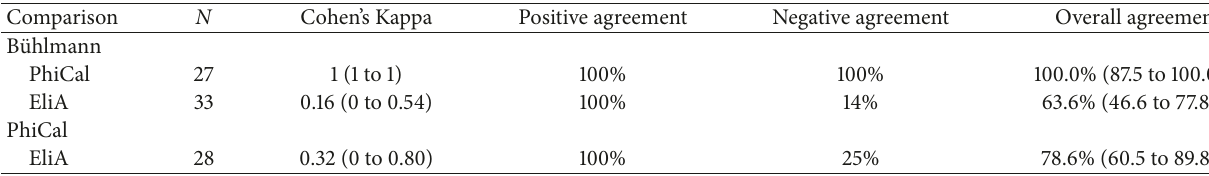
Table 5: Agreement between assays.